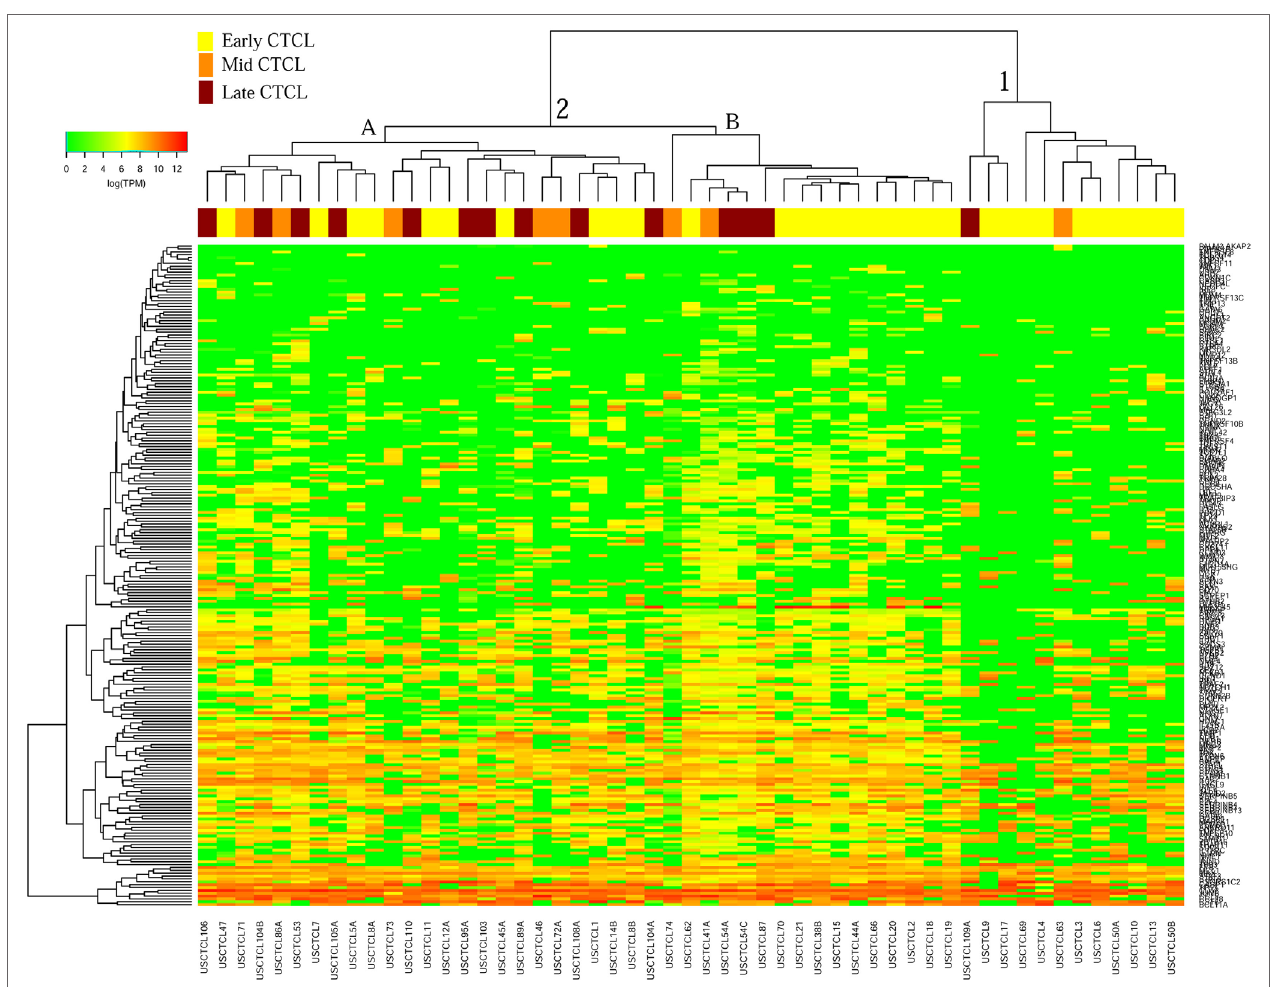
FigUre 5 | Unsupervised hierarchical clustering analysis based on TruSeq targeted RNA gene expression analysis of 284 select genes in ≤ 2008 early-stage (stage ≤ IIA, yellow), mid-stage (stages IIB and III, orange), and late-stage (stage IV, dark red) formalin-fixed paraffin-embedded cutaneous T-cell lymphoma (CTCL) samples. A color key refers to gene expression in log(transcripts per